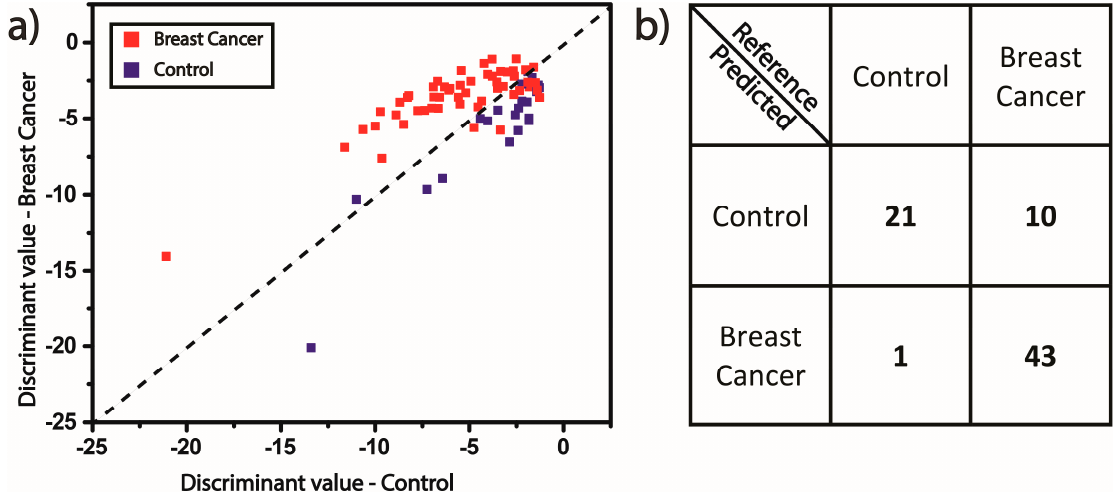
Figure 5. The principal component analysis - linear discriminant analysis (PCA-LDA) model yielded by SERS spectra acquired from the urine samples of patients with breast cancer (n = 53) and controls (n = 22). The discriminant values of the PCA-LDA model ( a ). The corresponding confusion matrix of the PCA-LDA model ( b ).